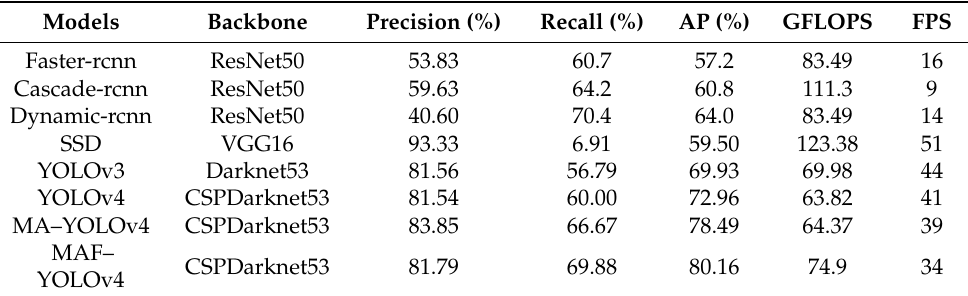
Table 2. Experimental results; score_threshold = 0.5; IoU = 0.5; GFLOPS indicates Giga Floating-point Operations Per Second; FPS indicates Frames Per Second.